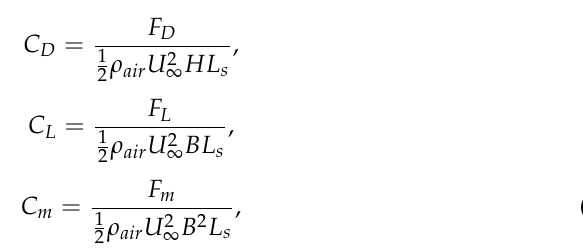
Figure 5. ( a – n ) The detailed geometry of the body-height grids I–XIV, respectively (unit: mm). 2.2.2. Leading Circular Cylinder Aerodynamic Interference The handrail is an important accessory of the bridge structure, which is usually com- posed of cylinders, and the cylinders disturb the incoming flow characteristics to change the boundary layer of the box girder. Therefore, with different smooth cylinders (diame- ters of 3 mm, 4 mm, 5 mm, and 6 mm) installed in front of the essential flow areas of the model (upper edge, middle upper region, leading edge, middle lower region, and lower edge), the effects of different flow characteristics of essential flow regions around the sec- tion model on the surface pressure distribution and aerodynamic response of the bridge deck were investigated, and Figure 6 shows the location of cylinders in front of the bridge deck with different spacing ratios. The spacing ratio ε is defined as the ratio of the distance S between the trailing edge of the cylinder and the frontal surface of the twin-box girder to the diameter of cylinder D , ε = S / D . The spacing ratios used in this study were 2, 3, 4, and 5. Figure 6. The sketch views of the leading circular cylinder and the twin-box girder ( D is the diameter of the circular cylinder).